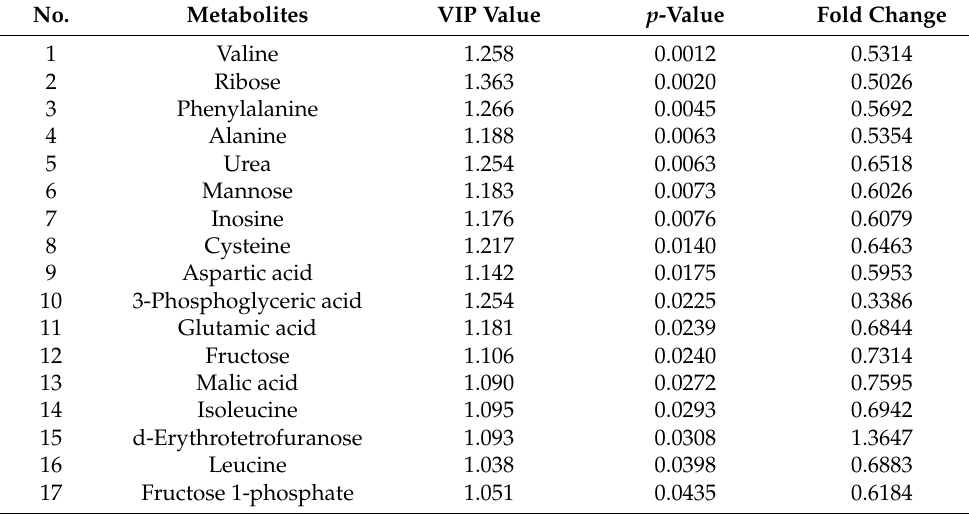
Table 1. Statistical results of comparison of short-term and long-term HBB exposure